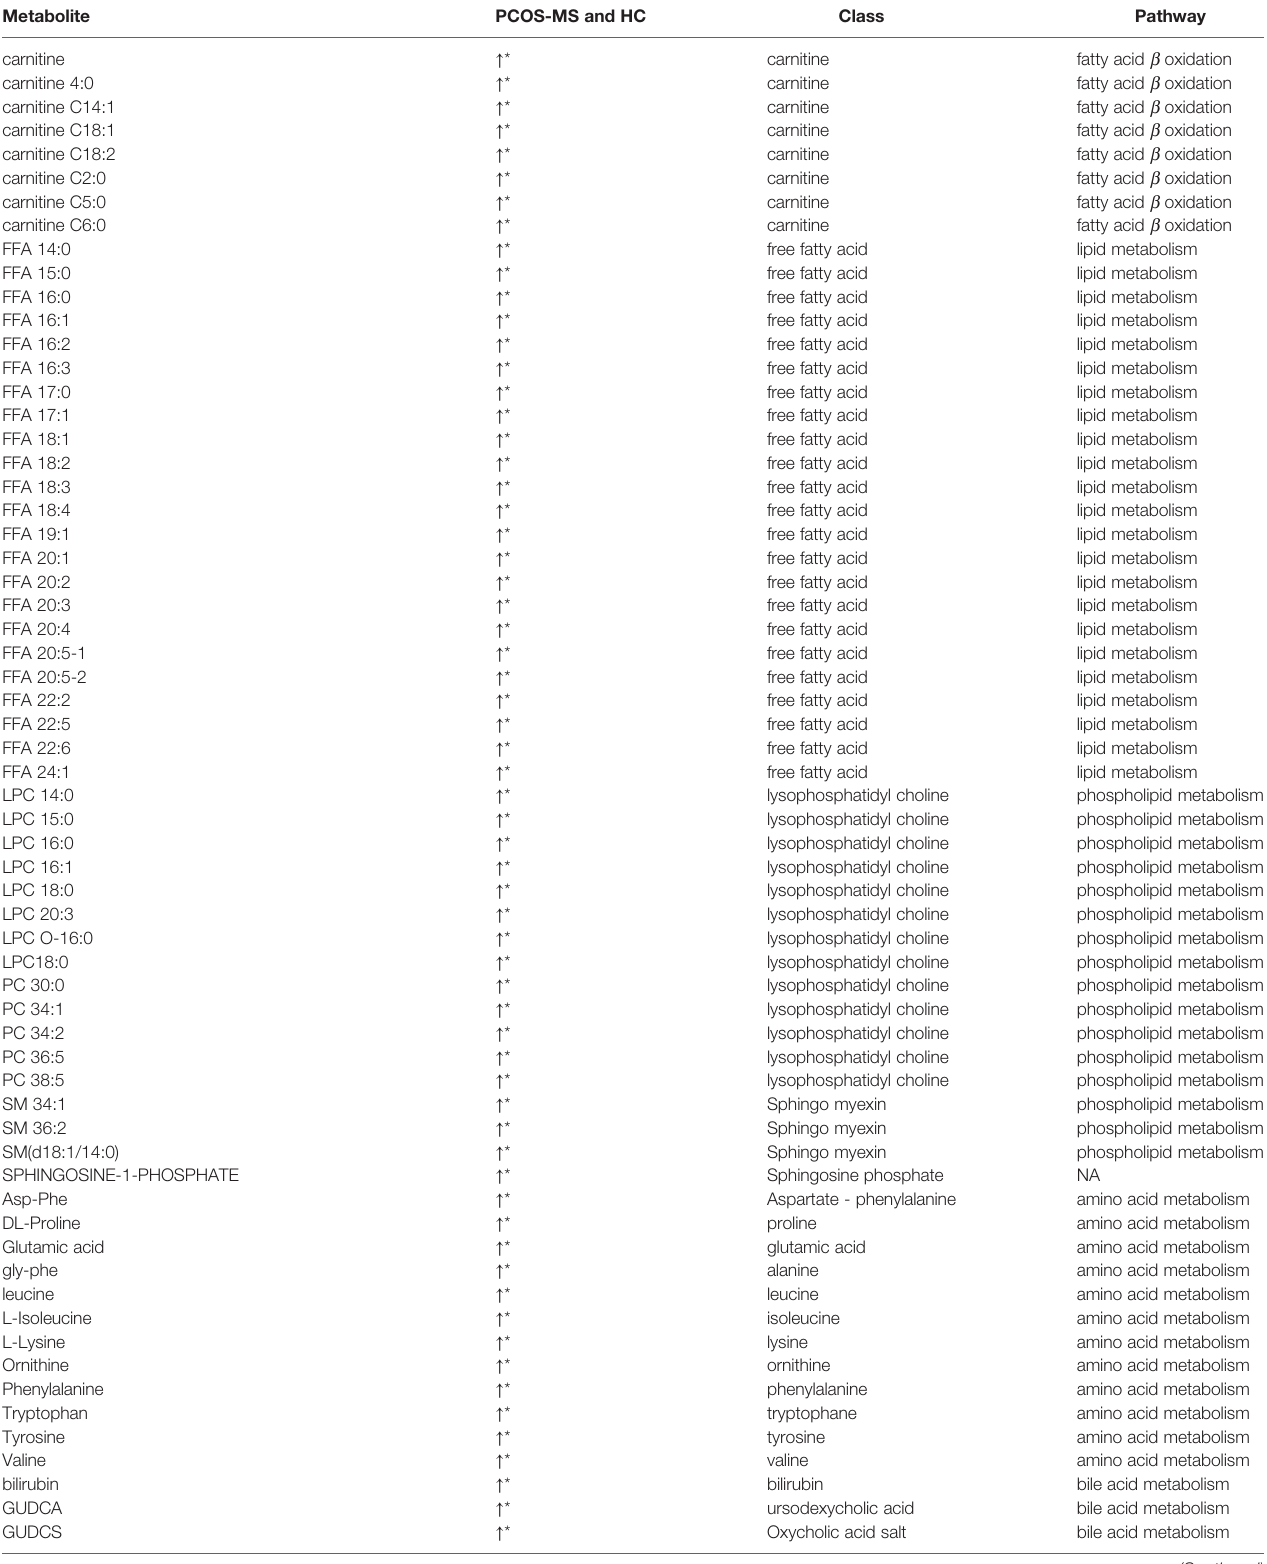
TABLE 3 | Differential metabolites between HC group and PCOS-MS